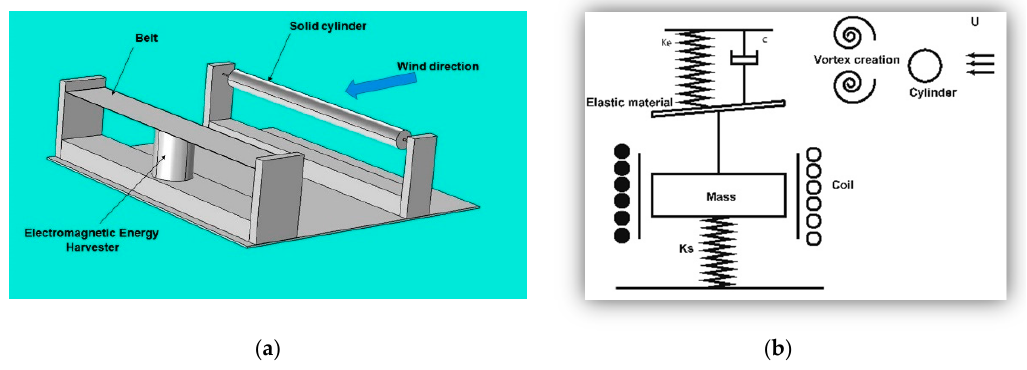
Figure 1. ( a ) Physical model configuration; ( b ) Architecture of the developed energy harvester.